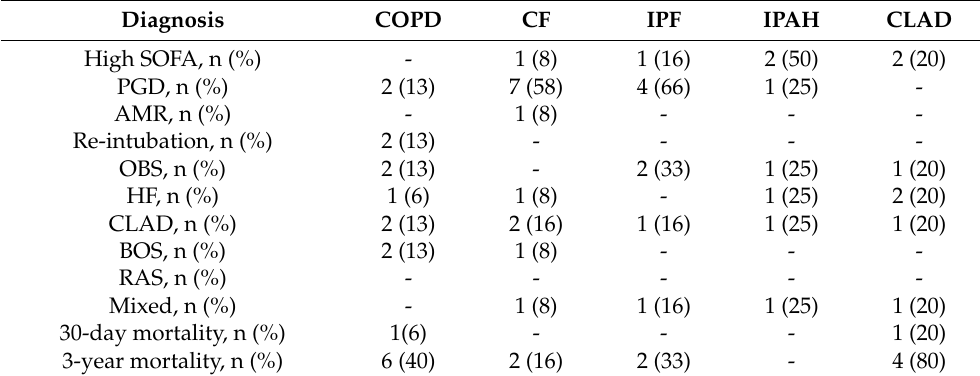
Table 3. Short- and long-term outcome of patients following lung